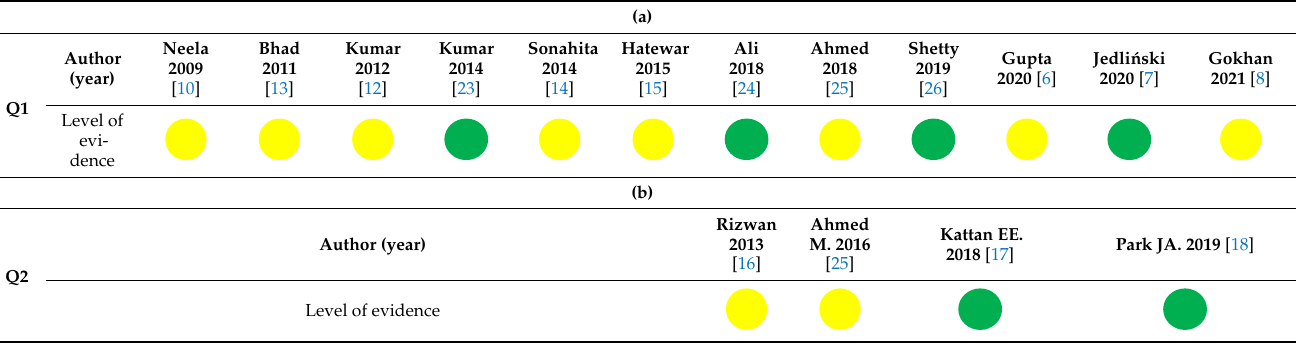
Level of evidence Level of evidence Yellow — moderate level of evidence, Green — low level of evidence. Yellow — moderate level of evidence, Green — low level of evidence. Yellow — moderate level of evidence, Green — low level of evidence. Yellow — moderate level of evidence, Green — low level of evidence. Yellow — moderate level of evidence, Green — low level of evidence. Yellow — moderate level of evidence, Green — low level of evidence.